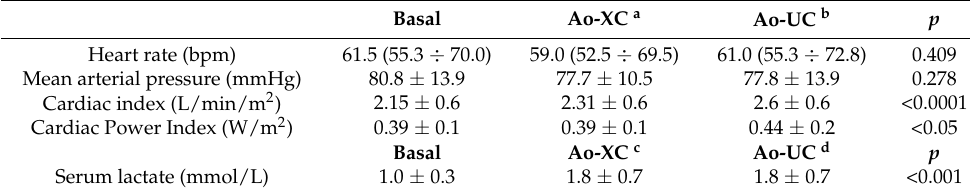
Table 2. Intraoperative cardiovascular performance.